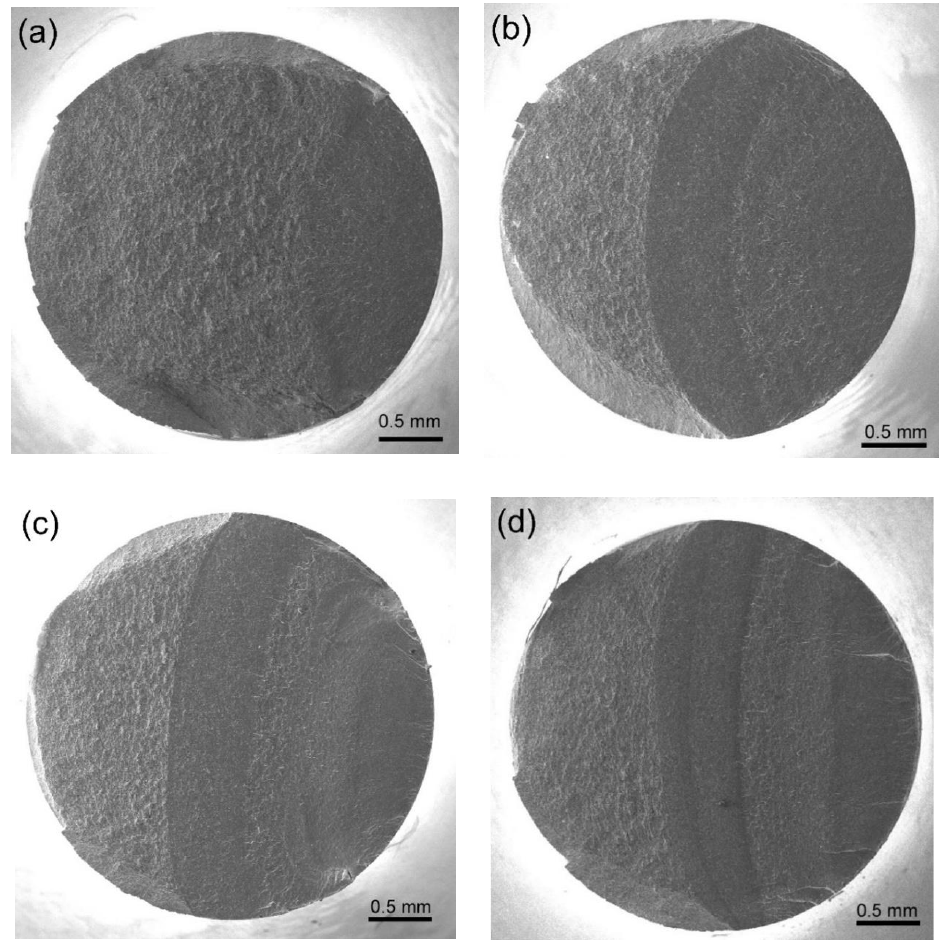
Figure 9. Typical macroscopic fracture surfaces of turned specimens failed at different fatigue lives: ( a ) σ a = 740 MPa, N f = 1 × 10 5 , ( b ) σ a = 700 MPa, N f = 1.5 × 10 6 cycles, ( c ) σ a = 660 MPa, N f = 6 × 10 7 cycles and ( d ) σ a = 640 MPa, N f = 3.29 × 10 8 cycles.